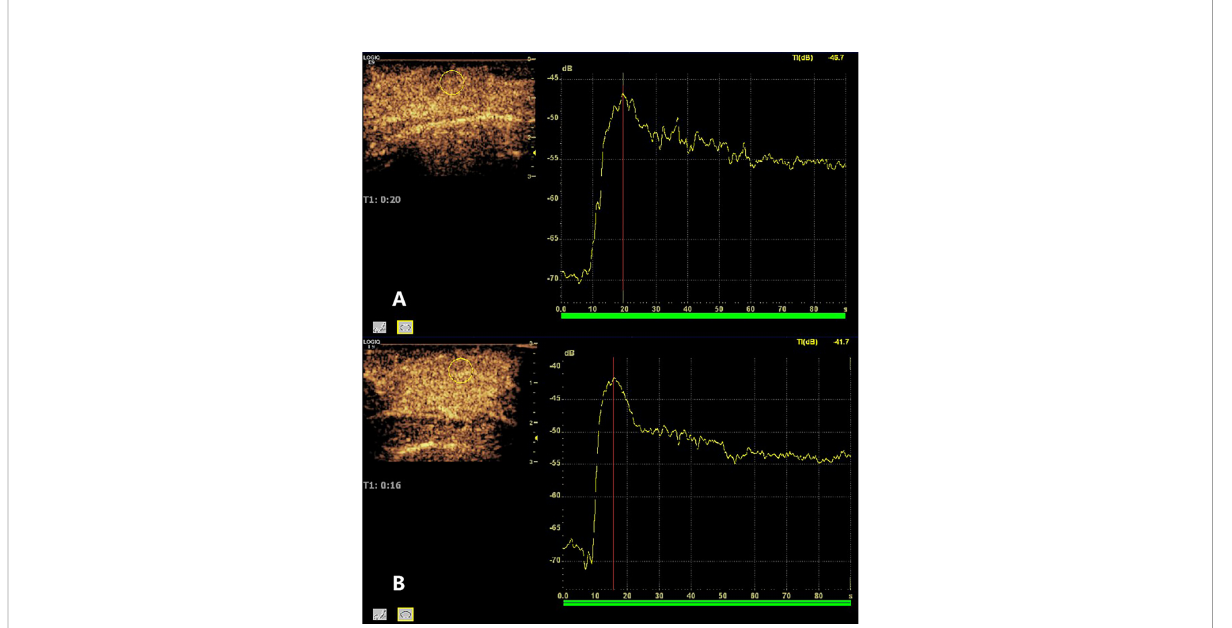
FIGURE 6 Changes in the CEUS TIC curve before and after ultrasonic therapy. (A) Before ultrasound treatment, peak intensity = -45.7dB, mean transit time = 74.00 s, area under curve =1560.317; (B) After ultrasound treatment, peak intensity = -41.7dB, mean transit time = 85.60s, and area under the curve =